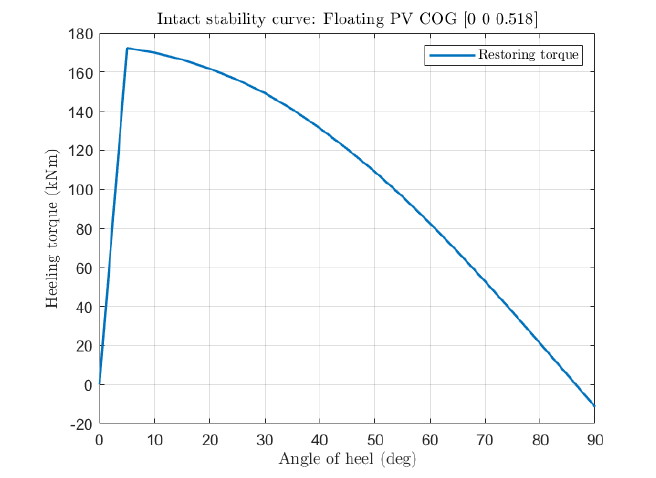
Figure 10. Intact stability curve of the floating foundation.